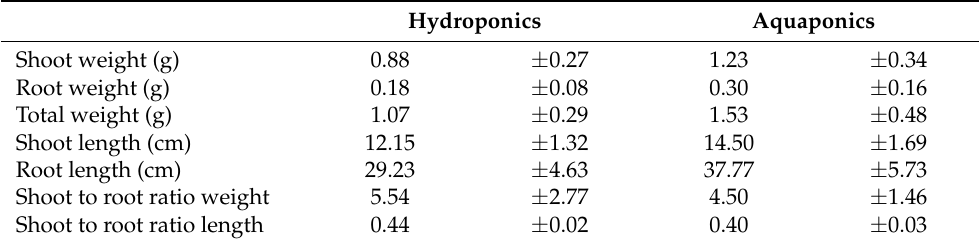
Table 2. Dry weights for shoots and roots, plant total dry weight, shoot and root length, and shoot to root ratio for weight and length of spinach ( Spinacia oleracea ) grown in hydroponic and aquaponic system for 42 days. In the aquaponics treatment spinach was grown in a coupled aquaponics system together with rainbow trout ( Oncorhynchus mykiss ).